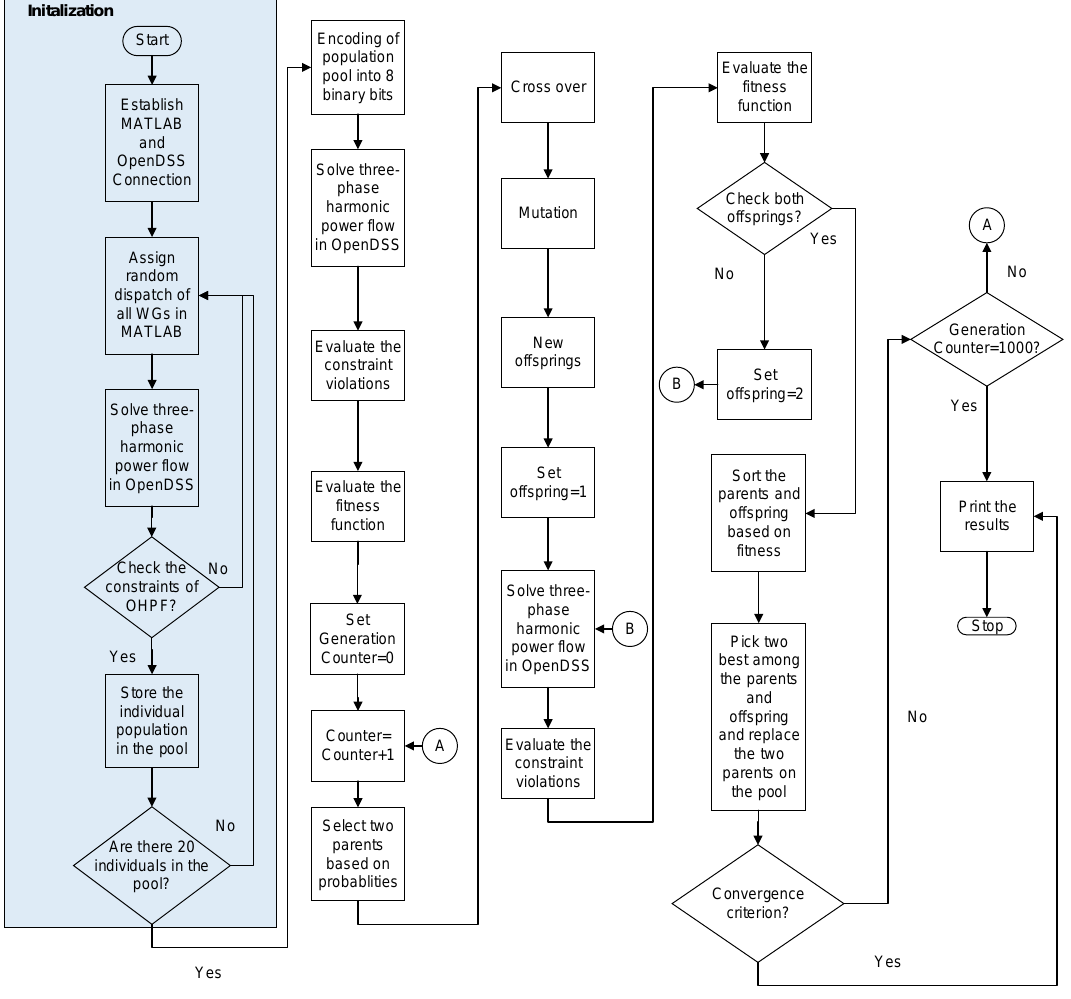
Figure 4. Flowchart of the solution algorithm where a Genetic Algorithm (GA)-based optimization algorithm is built in MATLAB and a harmonic power flow model is built in OpenDSS.